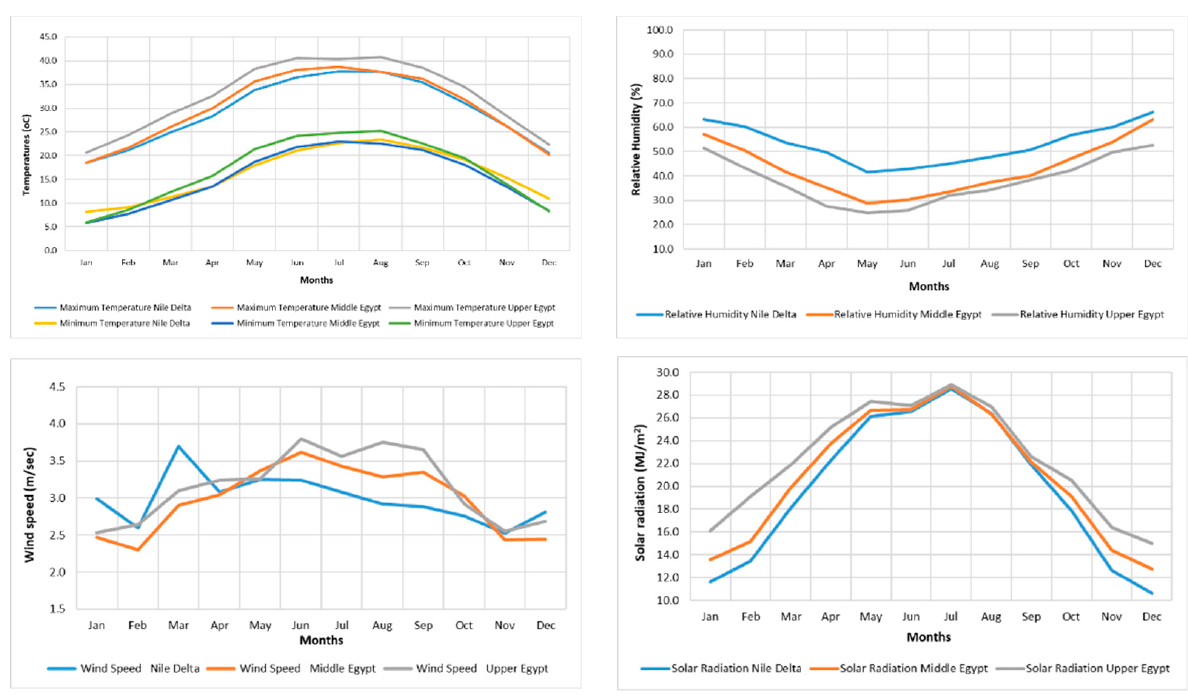
Figure 2. Mean monthly maximum and minimum temperatures, relative humidity, wind speed, and solar radiation in the three study areas.